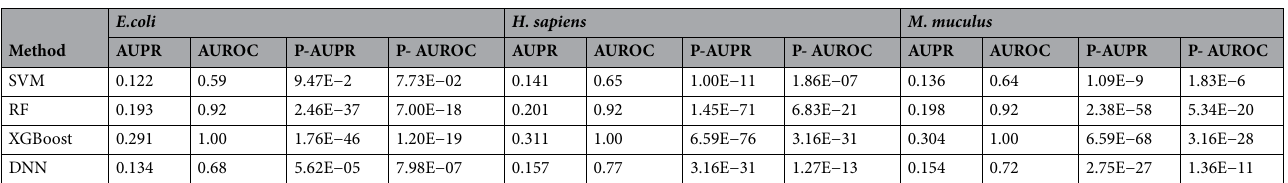
Table 4. The values of AUROC, AUPR and their P-values for various classifiers and